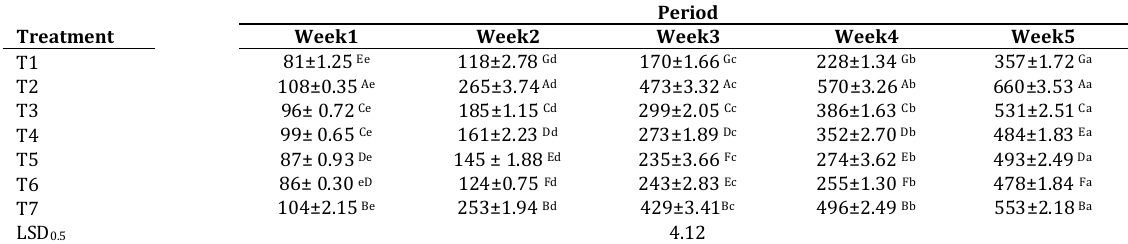
Table 3. Effect of different levels of Spirulina , probiotic, prebiotic, and antibiotic with or without E. faecalis infection on weekly live body weight gain (g) of broilers